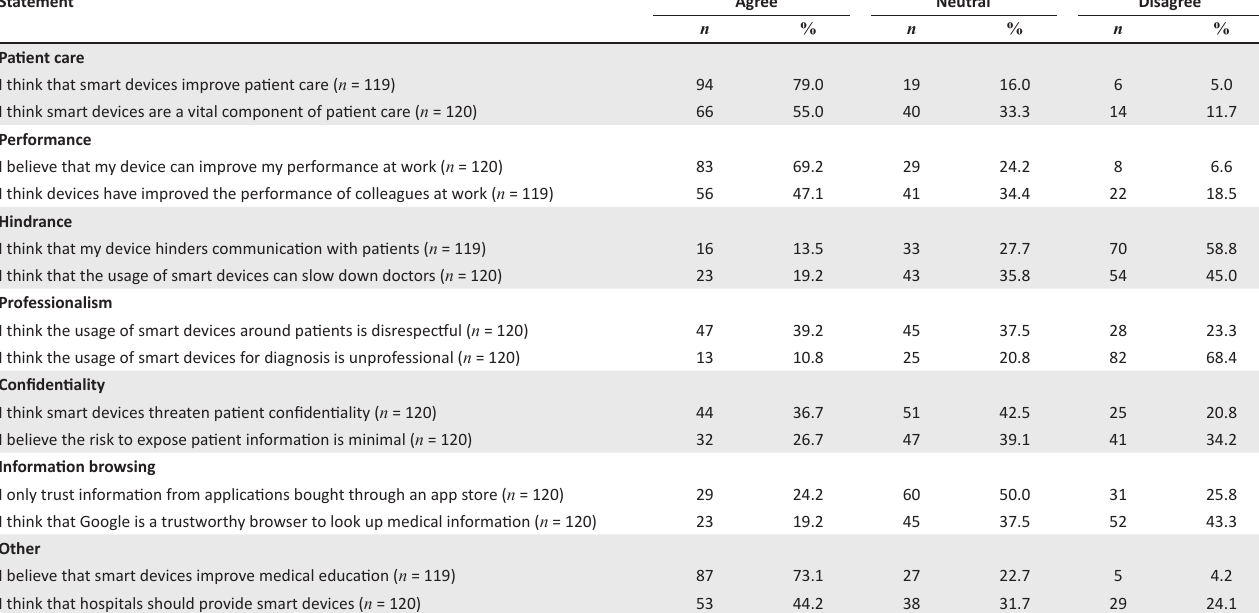
TABLE 4: Perceptions and practices of medical practitioners on the work-related use of smart devices. Statement